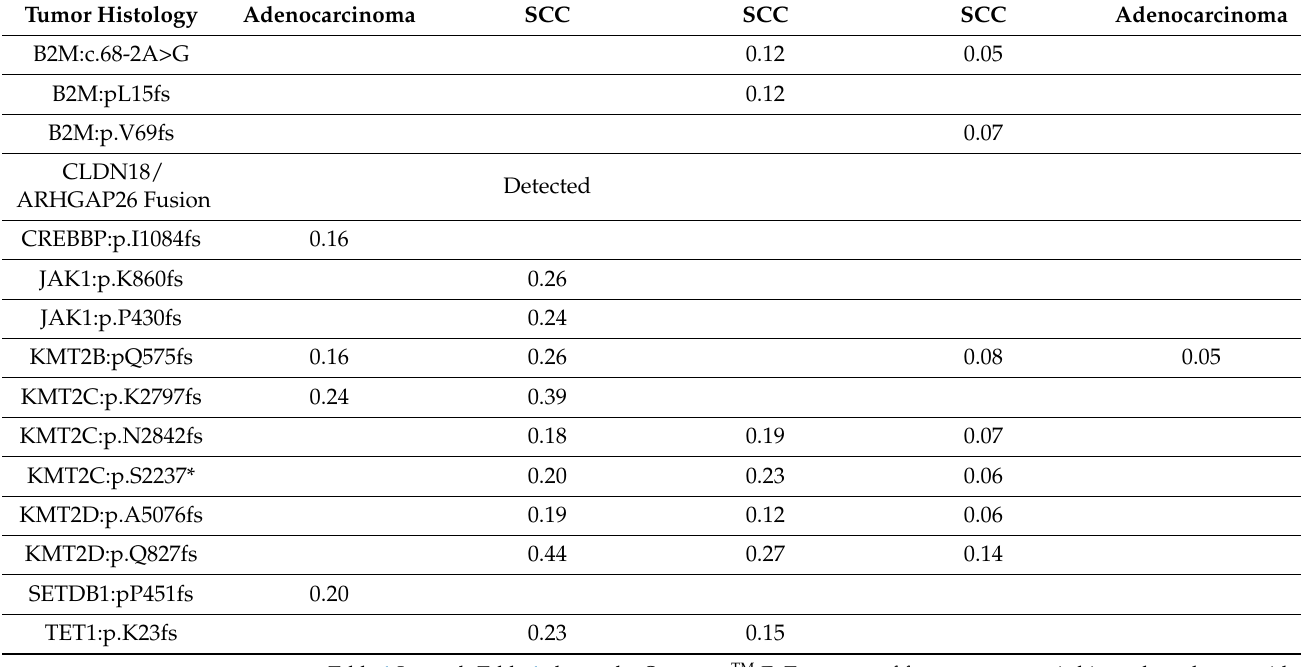
Table 1 Legend: Table 1 shows the Oncomap TM ExTra report of front-page somatic biomarkers that are either druggable, have clinical trial enrollment, or may be of interest due to prognostic or therapeutic relevance.